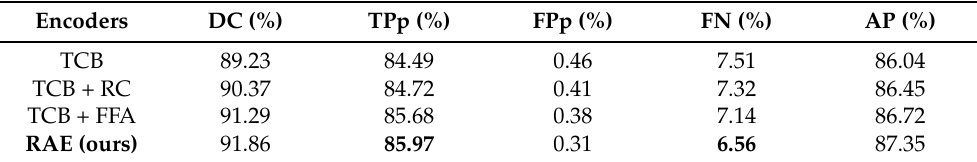
Table 1. The impact of our RAE module on model performance.